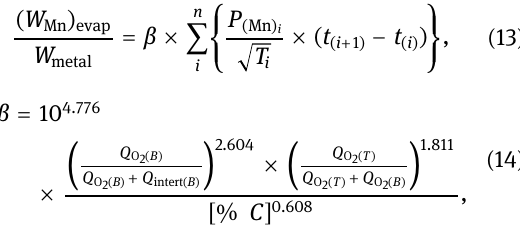
Table 5: Gibbs free energies of di ff erent manganese oxides